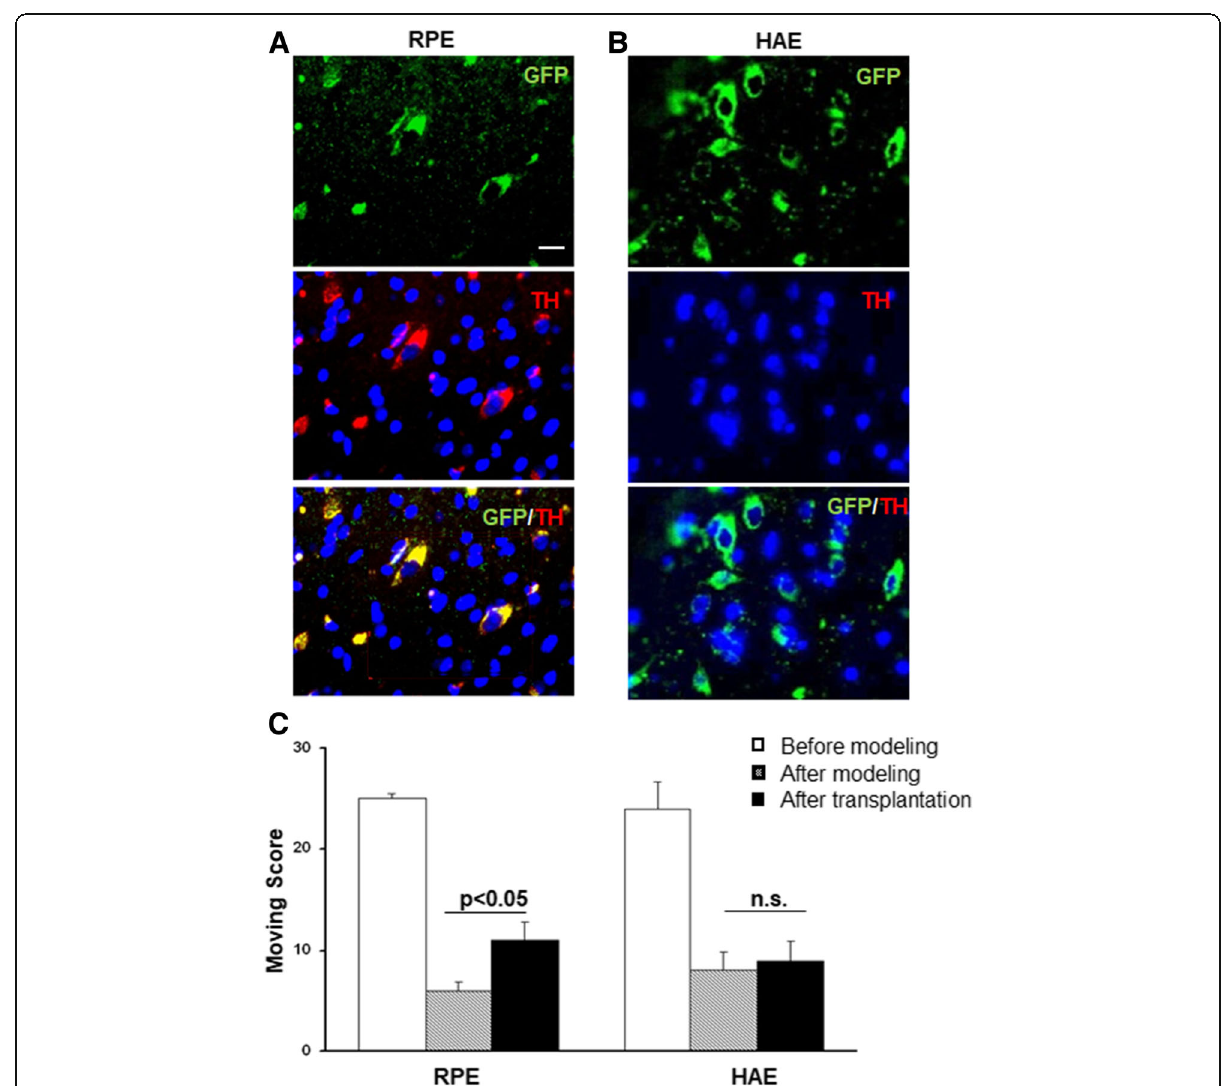
Fig. 4 Human RPE cells differentiated into dopaminergic-like cells in the brains of monkeys after being transplanted into the striatum. a - b Immunofluorescent staining of tyrosine hydroxylase (red) in GFP-labeled human RPE cells ( a ) or HAE cells ( b ) (scale bar: 10 μ m). c Spontaneous movements score for control, PD, or PD monkeys after transplantation with RPE cells (left panel) or HAE cells (right panel), data are expressed as